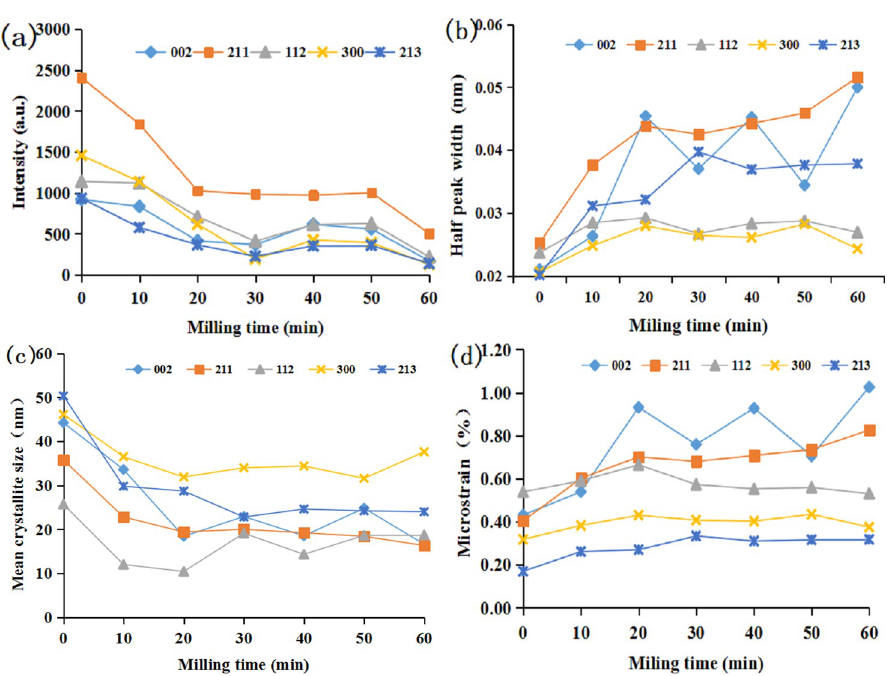
Fig 5. Changes in the main apatite crystal surfaces depending on the milling time detected by XRD: (a) peak intensity; (b) half peak width; (c) mean crystallite size; (d) microstrain.